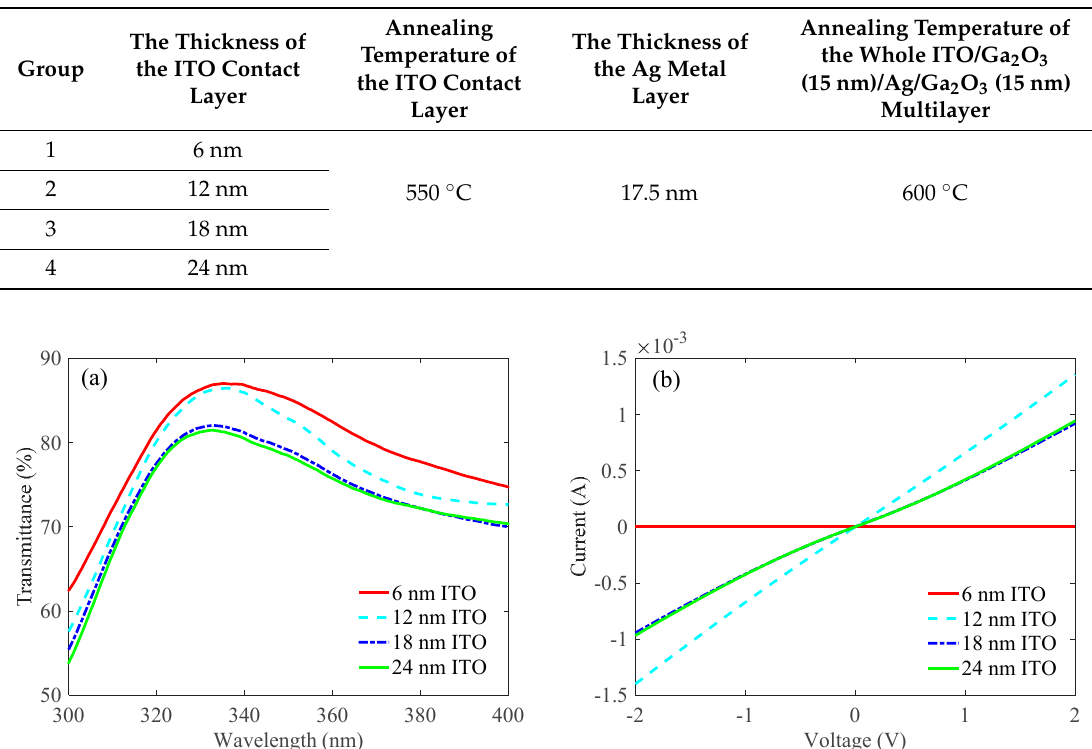
Table 2. The experimental design matrix for optimal thickness of the ITO contact layer.